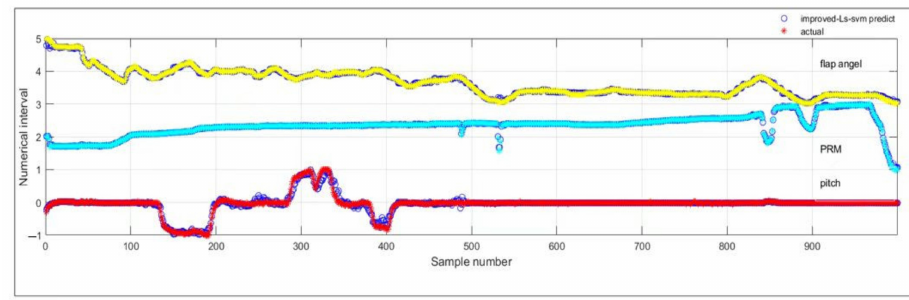
Figure 5. Climbing phase simulation